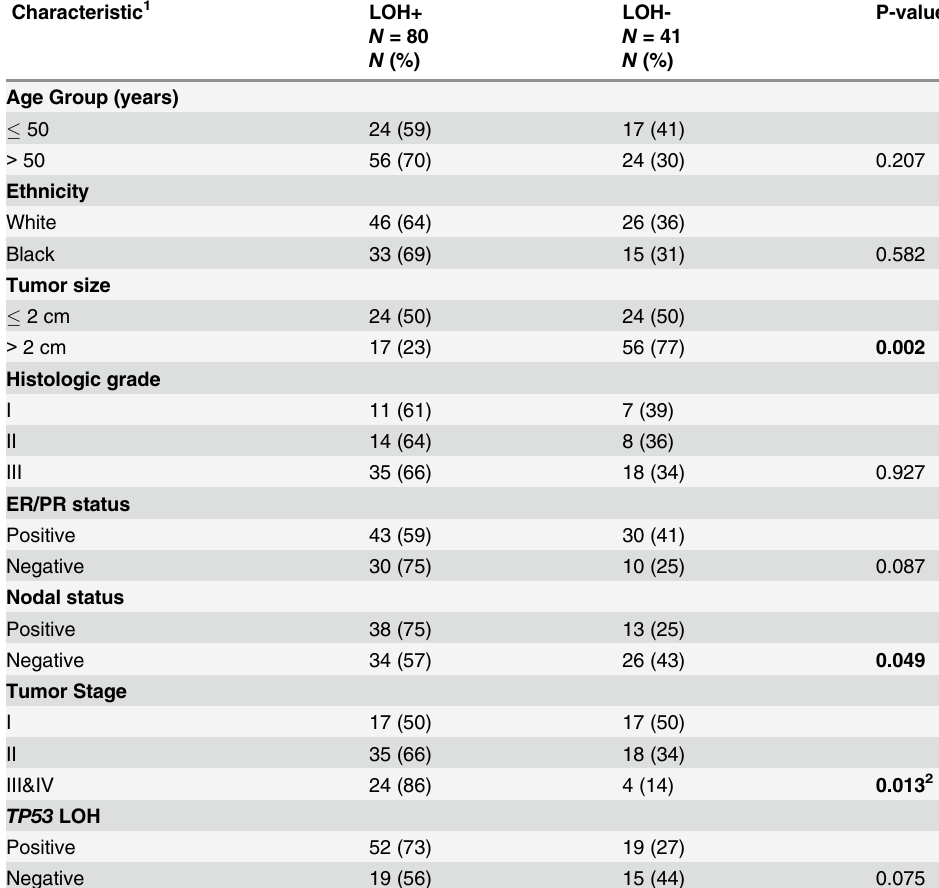
Table 4. Relationship between clinicopathological features and LOH status at 17p13 . 3 of the RPH3AL gene in breast cancers. Characteristic